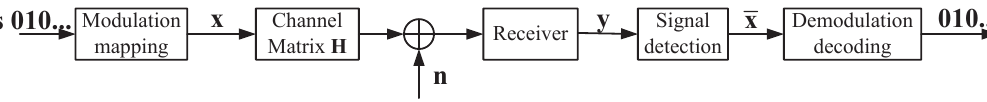
Figure 1. The structure of multiple-input-multiple-output (MIMO) signal